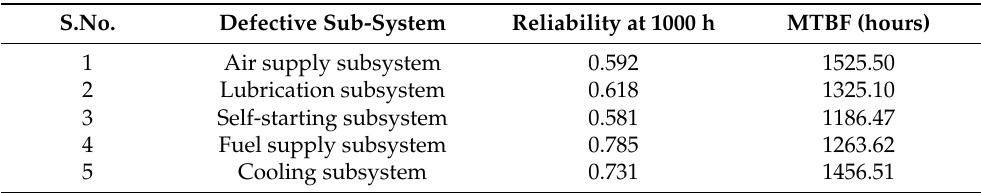
Table A1. Reliability and MTBF for all five